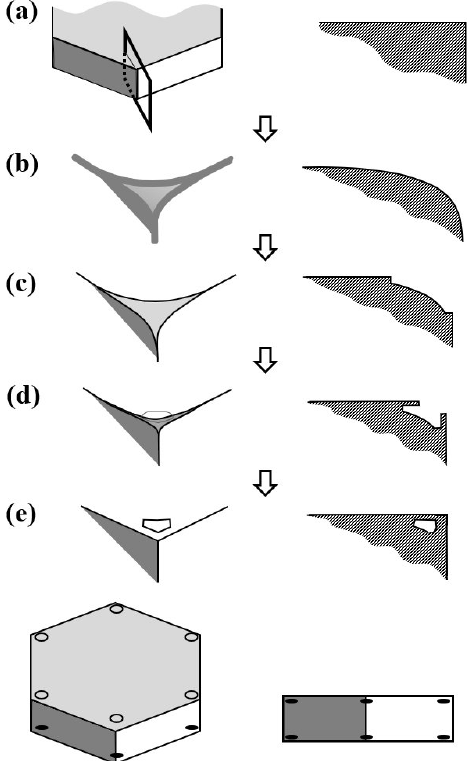
Figure 4. Corner-pocket formation after sublimation rounding. (a) Oblique (left) and cross-section (right) view of edge of a tabular crystal during growth. The top face is basal; the sides are a prism. (b) Same views after net sublimation rounded the edge. (c) After growth conditions resume. Basal and prism have facet-edge fronts (same as Fig. 2b). (d) Protruding growth begins. (e) Corner pocket forms. Overall oblique and front view at the